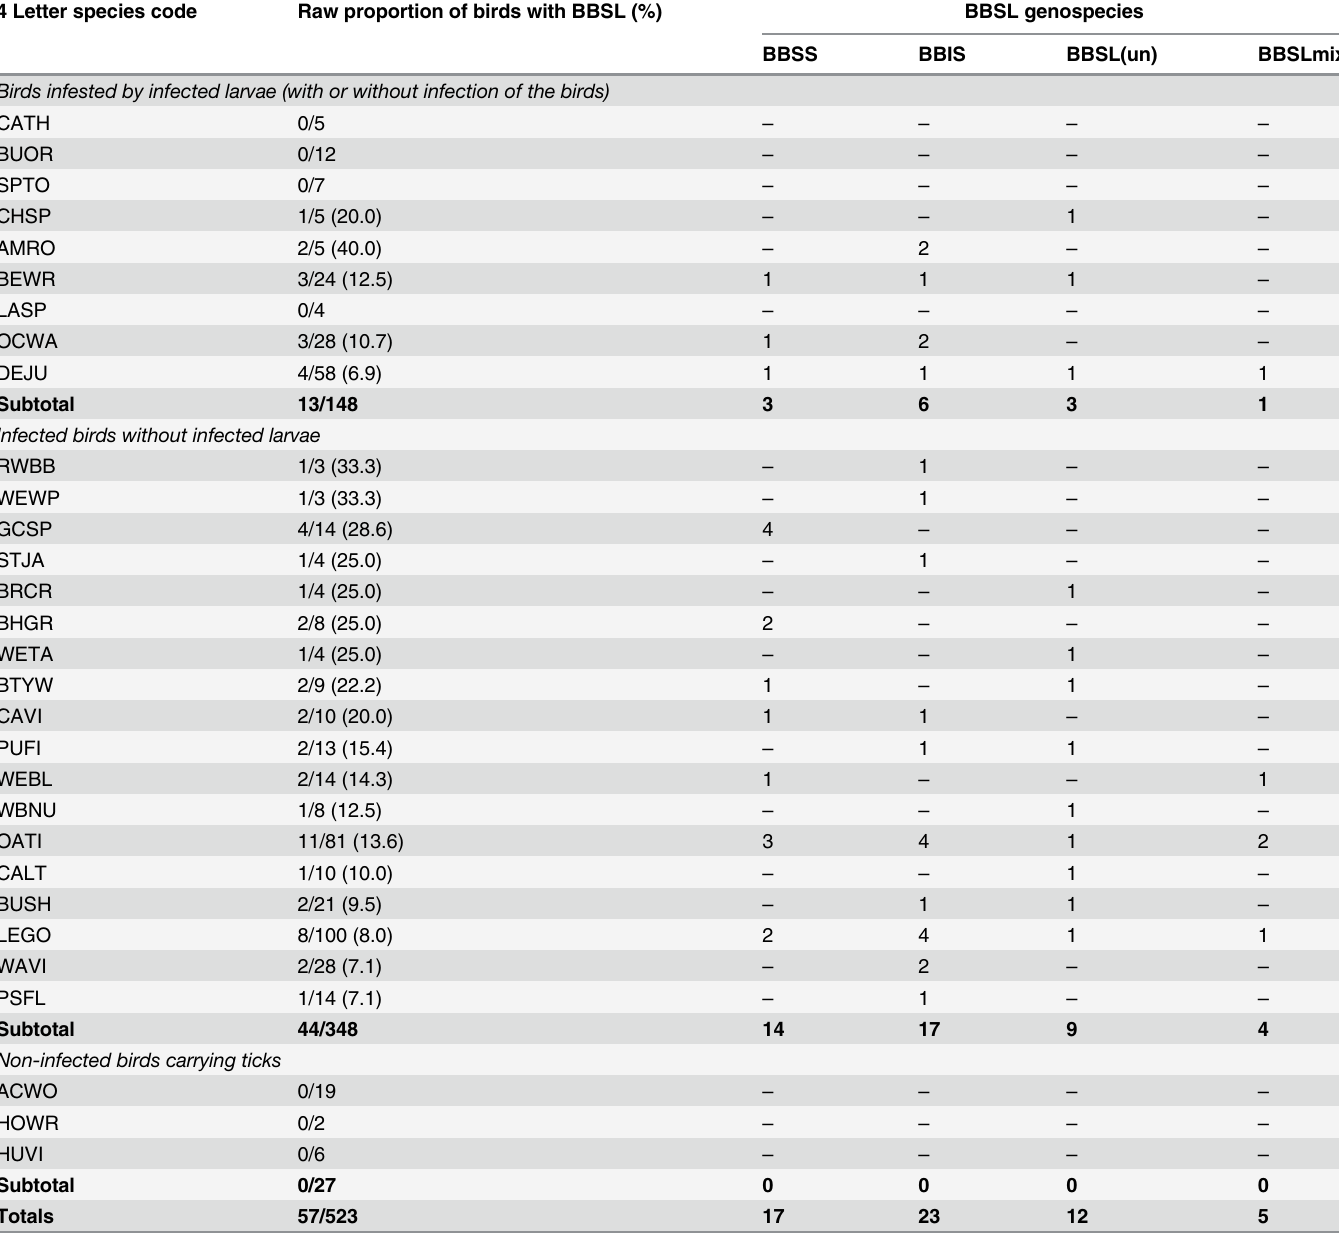
Table 5. Summary of B . burgdorferi s.l. genospecies found in